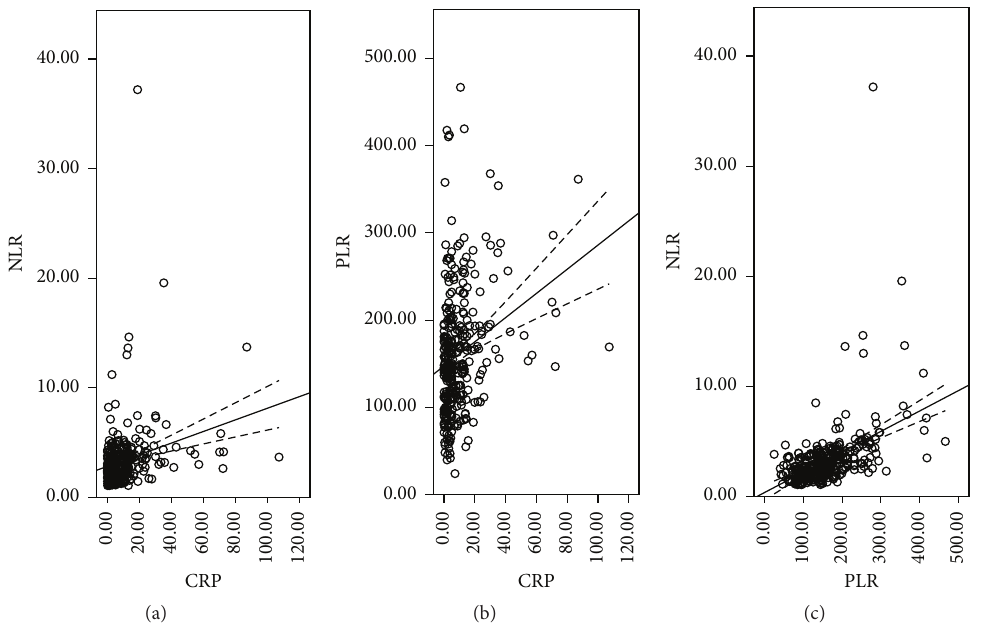
Figure 2: Pearson correlation analysis. Positive correlations in CRP and NLR ( 𝑟 = 0.258 , 𝑃 < 0.001 ; (a)), CRP and PLR ( 𝑟 = 0.265 , 𝑃 < 0.001 ; (b)), and NLR and PLR ( 𝑟 = 0.470 , 𝑃 < 0.001 ;